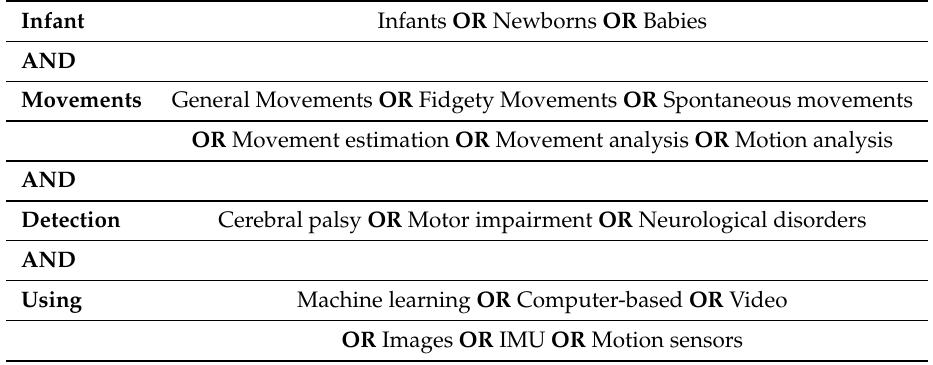
Table 1. The literature search strategy